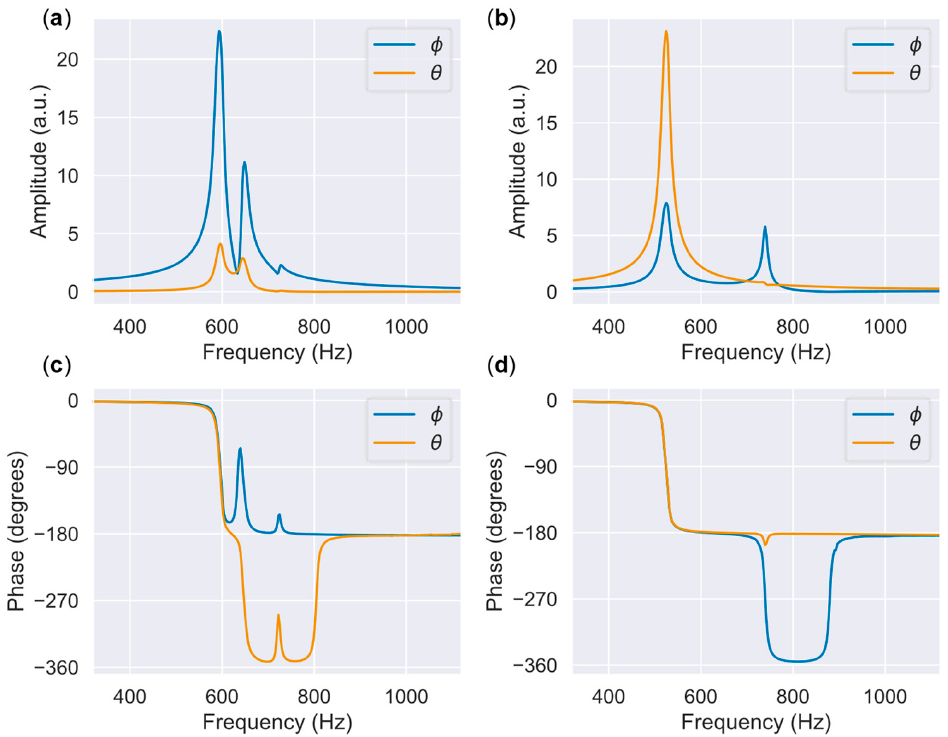
Figure 8. Frequency response: Frequency-amplitude characteristics under ( a ) x -axis actuation and ( b ) y -axis actuation; frequency-phase characteristics under ( c ) x -axis actuation (PAx+/ − ) and ( d ) y -axis actuation (PAy+/ − ).